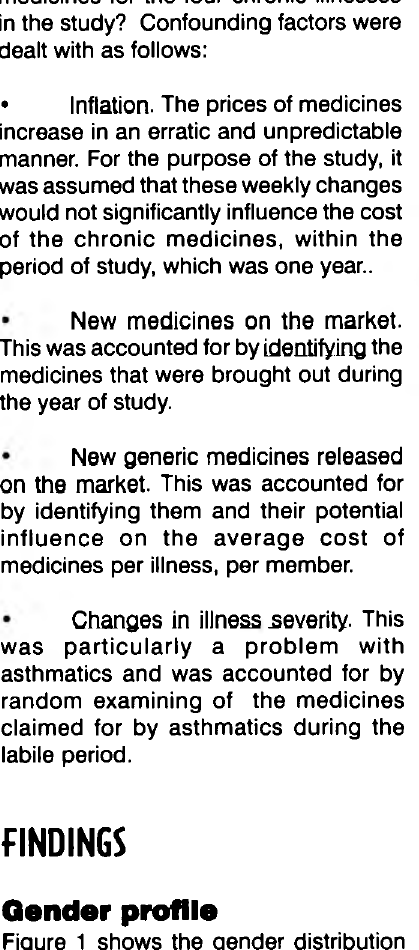
Figure 1: Bar graph depicting the gender profile of the members who had